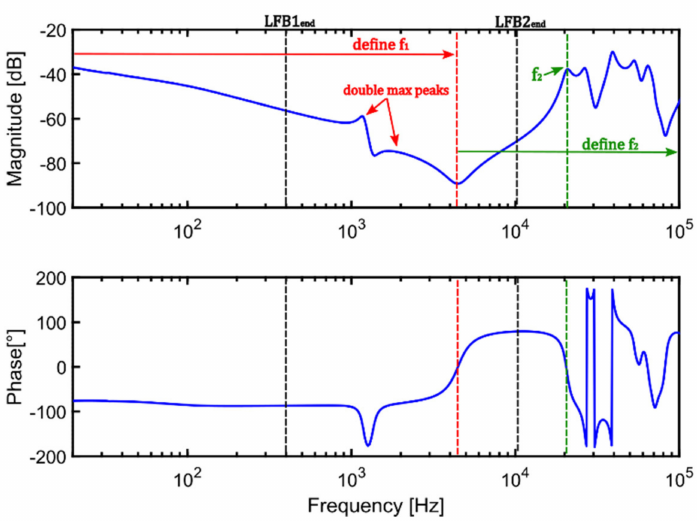
Figure 8. An example of class 2 FRA plot for identification of the LFB1end and LFB2 end